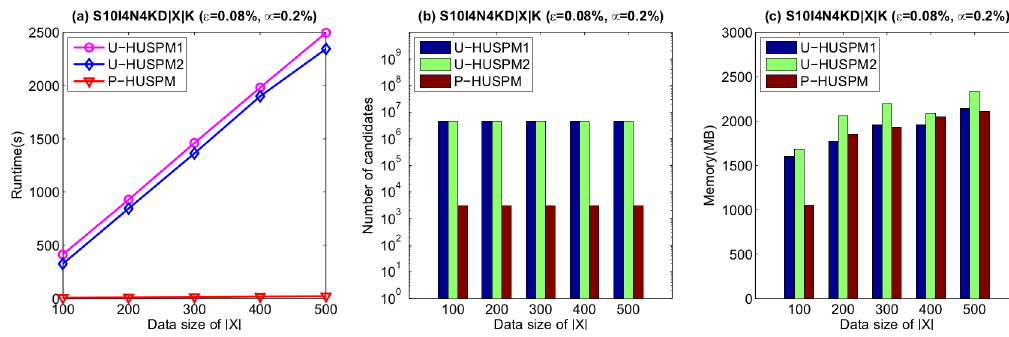
Fig 7. Scalability of the compared